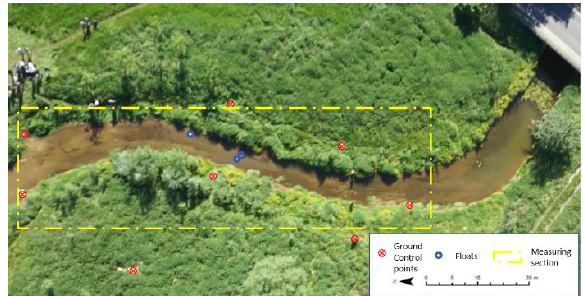
Figure 1. A true color image of the study area captured by UAS in 2018